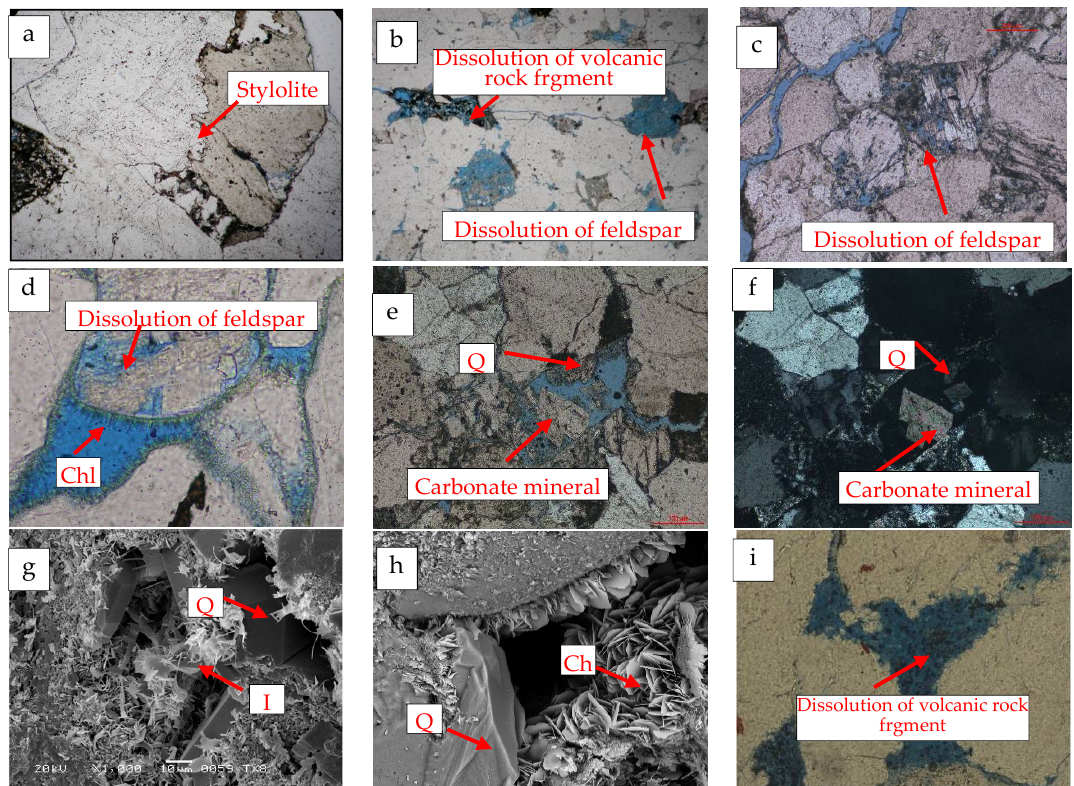
Figure 3. Photomicrographs showing the diagenesis characteristics of the Xu2 sandstones. ( a ) Stylolite contact of the quartz detrital grains, CG561 well, 4926.65 m, plane-polarized light (PPL) analysis; ( b ) Dissolution of feldspar and volcanic rock fragments associated with fractures, intragranular dissolution pores, CX565 well, 4898.31 m, PPL; ( c ) Dissolution of feldspar associated with fractures, intragranular dissolution pores, ZT1 well, 3667.6 m, PPL; ( d ) Dissolution of feldspar and chlorite layer, CG561 well, 4992.9 m, PPL; ( e ) Dissolution of feldspar, carbonate mineral recrystallization, ZT1 well, 3673.05 m, PPL; ( f ) Dissolution of feldspar, carbonate mineral recrystallization, ZT1 well, 3673.05 m, XPL; ( g ) Illite and authigenic quartz cements, X10 well, 4880.24 m, SEM; ( h ) Chlorite-coated and authigenic quartz cements, JH2 well, 3440.42 m, SEM; (i) Dissolution of volcanic rock, CG561 well, 4993.54 m.